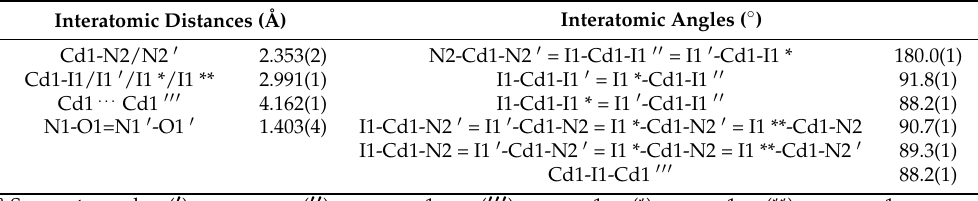
Table 4. Selected interatomic distances (Å) and angles ( ◦ ) for the polymeric compound {[CdI 2 (4paoH) 2 ]} n ( 3 ) a .